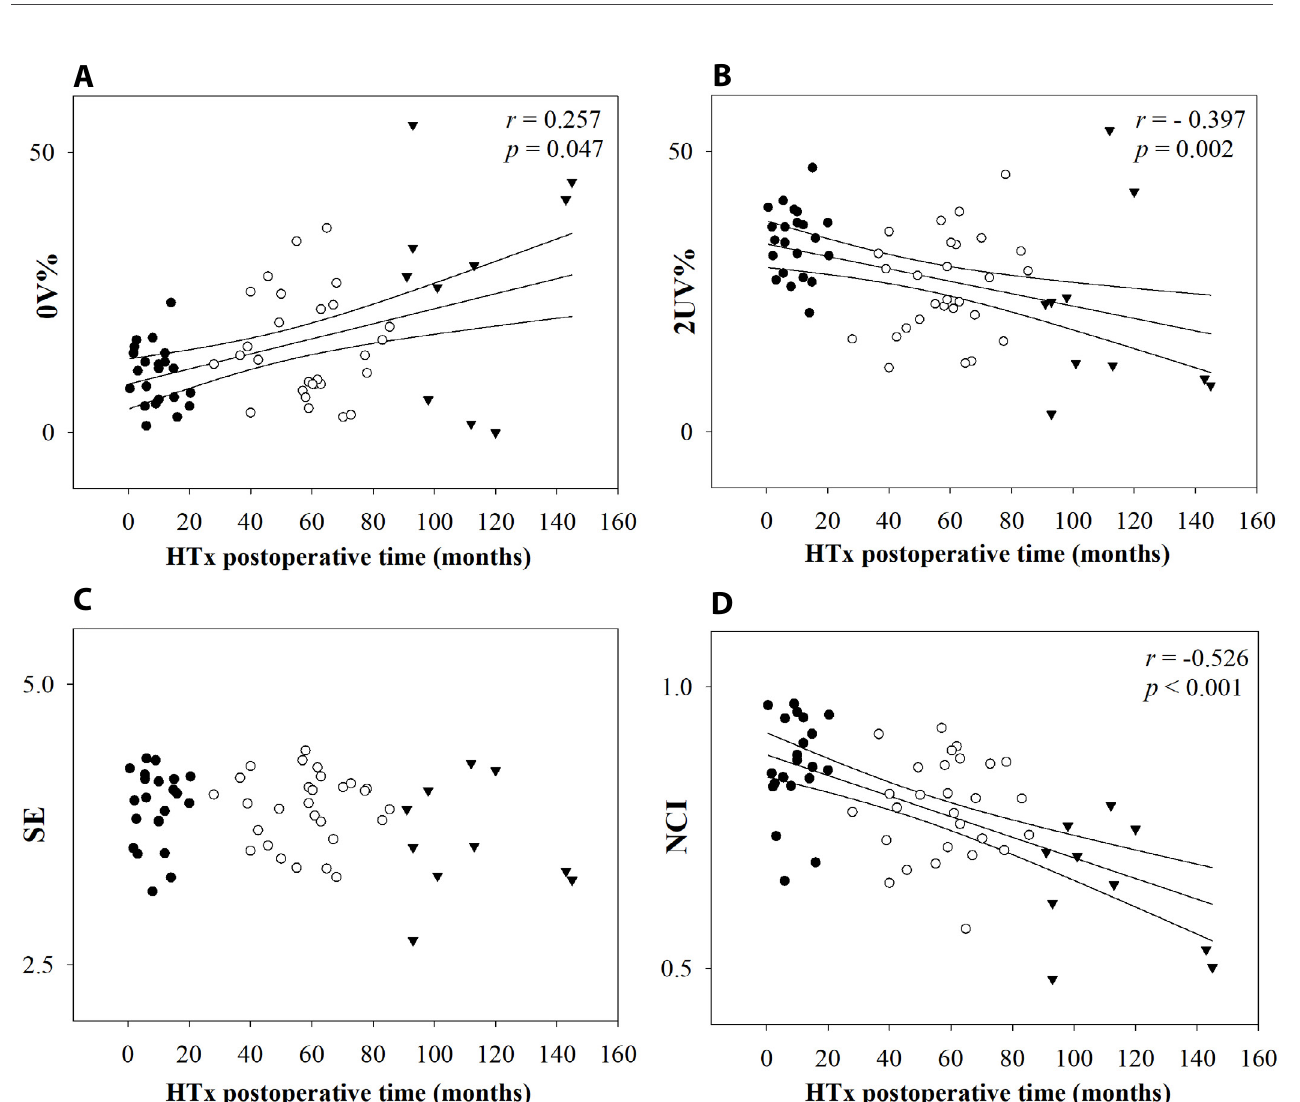
Fig. 3 – Relation between symbolic dynamics indexes and heart transplantation (HTx) postoperative time. Linear regression and its 95% confidence interval of 0V% (A), 2UV% (B), Shannon entropy (SE) (C), and normalized complexity index (NCI) (D). Group 1 is represented by l , Group 2 is represented by O , and Group 3 is represented by q in graphs a, b, c and d. P-value is indicated in each graph when there are